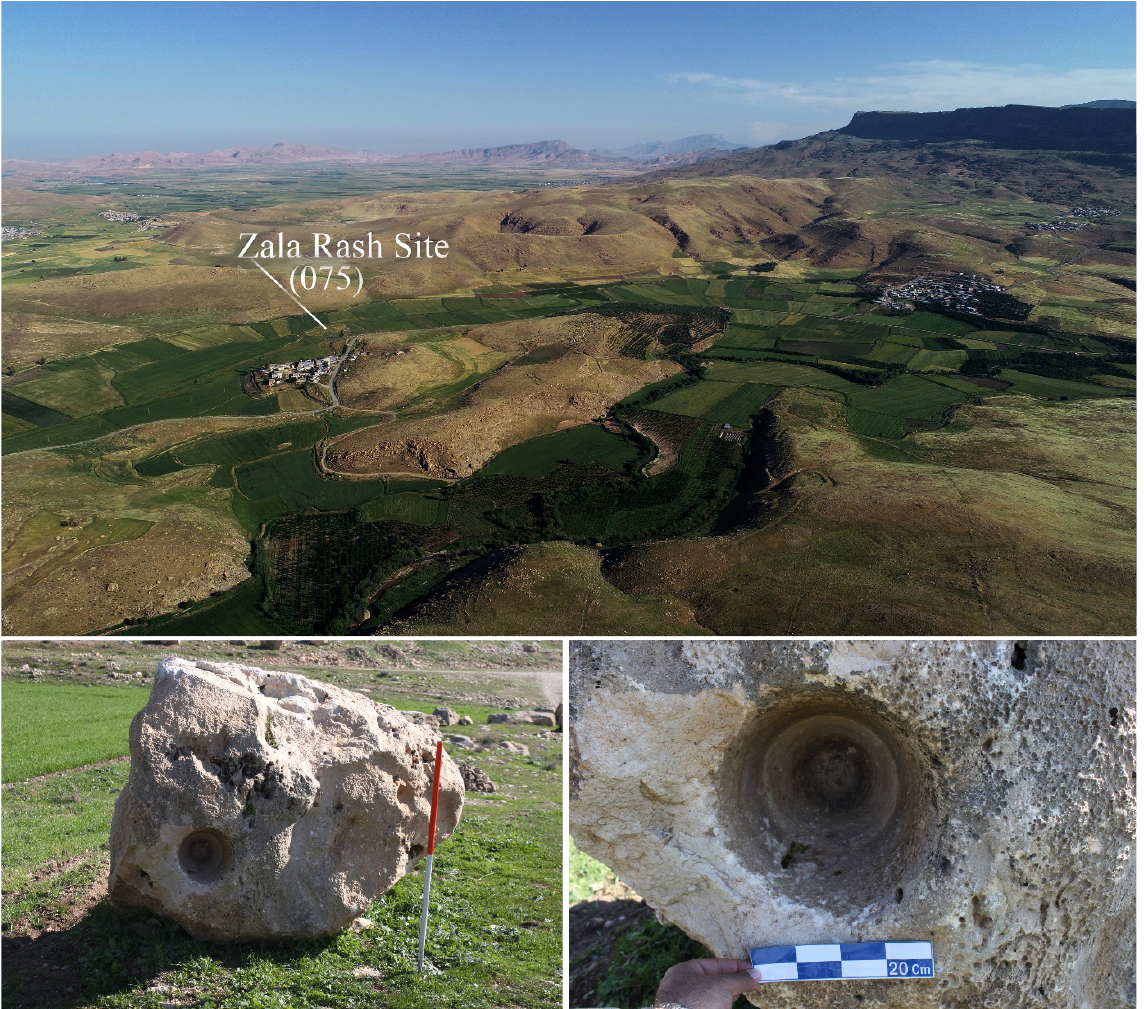
Figure 5. Aerial view of Zala Rash and its rock mortar (courtesy of Reza